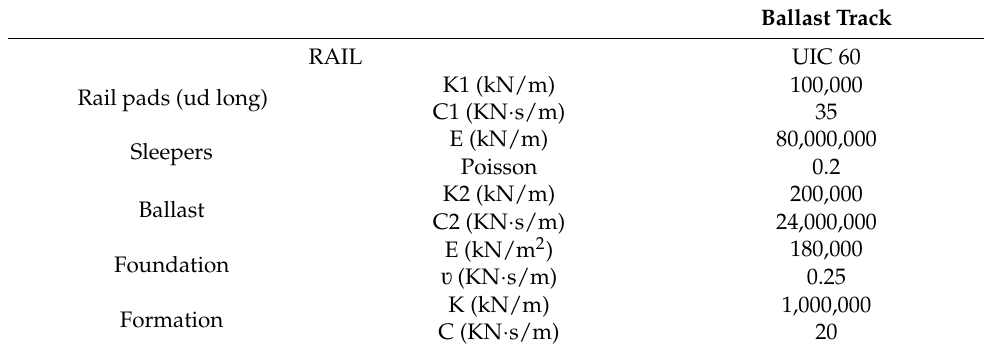
Table 1. Mechanical parameters of the track superstructure elements used in the track model.